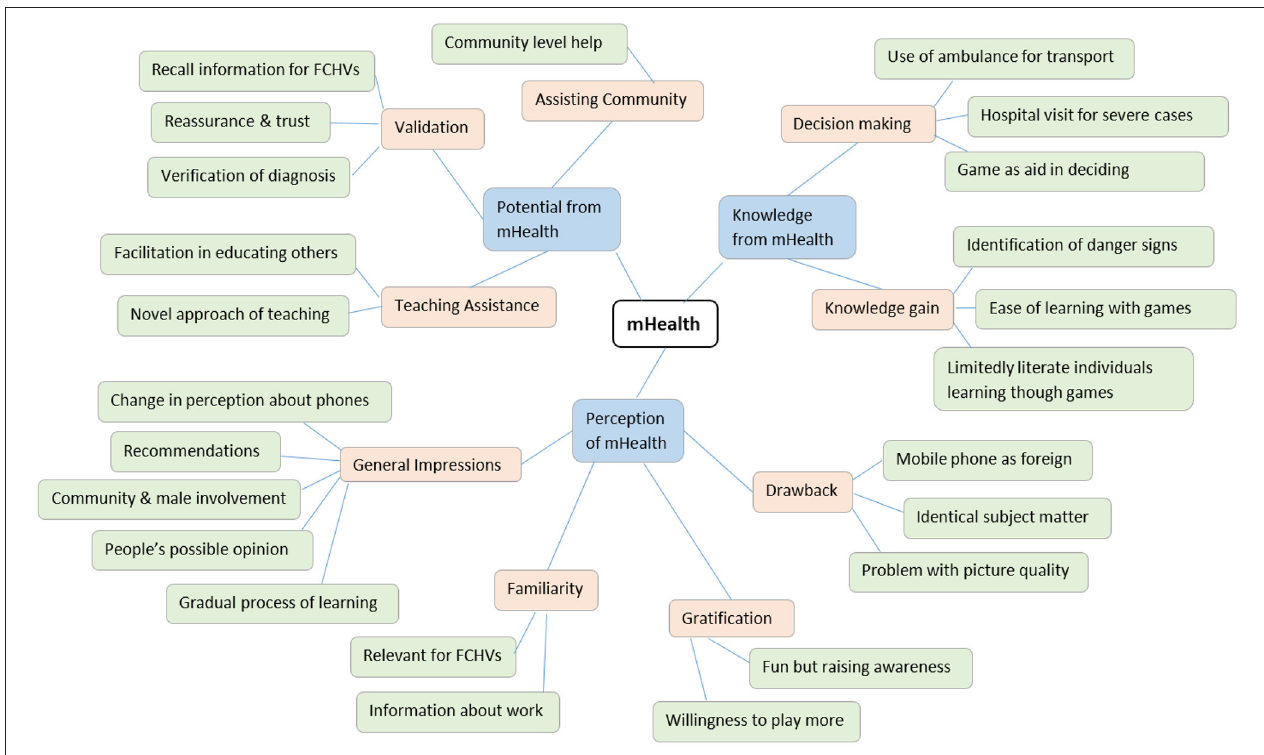
FIGURE 4 | Mind Map to organize data.